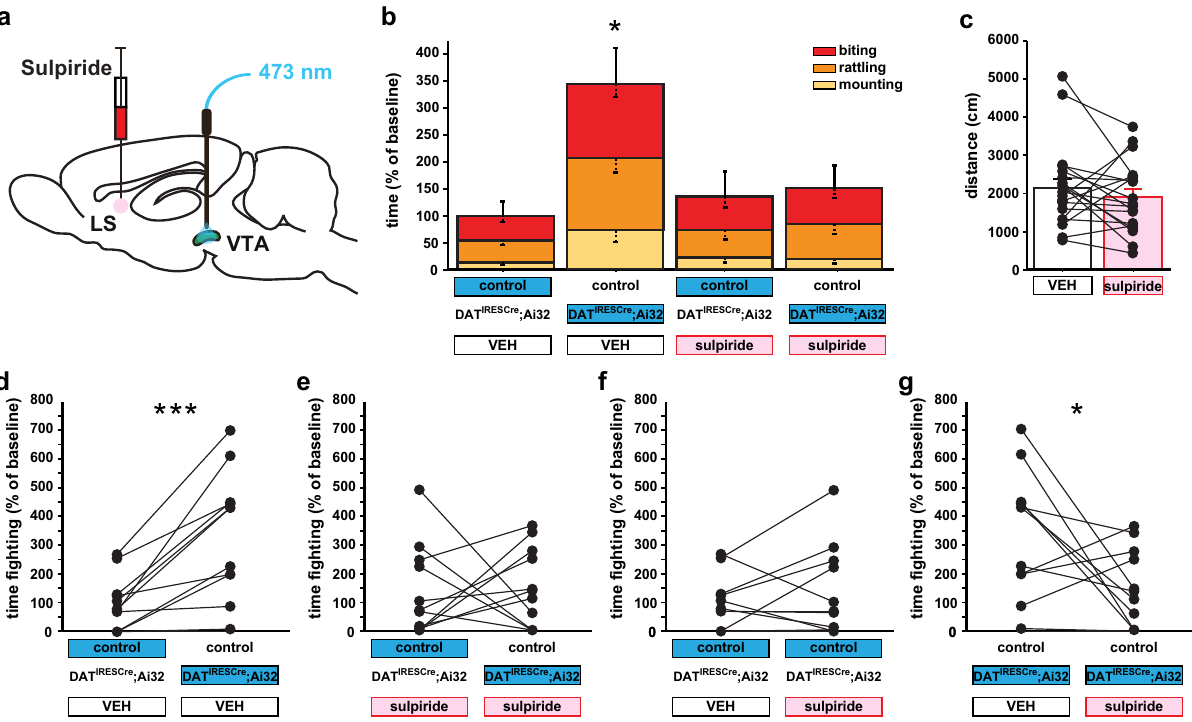
Fig. 7 D2 receptor activation in the LS is necessary for VTA DAergic activity to increase aggression. a The schematic diagram for local infusions of sulpiride in the LS followed by optogenetic stimulation (blue) of the VTA to evoke in vivo non-projection speci fi c DA release. b Local sulpiride infusion into the LS prevents aggression elicited by optogenetic activation of VTA DAergic activity. c No difference in locomotion was detected between the groups following local infusion of sulpiride in the LS. Time- fi ghting, for individual pairs, is broken down by d , e treatment and f , g stimulation condition. * P < 0.05; *** P < 0.001 compared with their respective controls; mean ± SEM; n = 11 pairs ( b , d – g ) and 20/group ( c ). VEH,